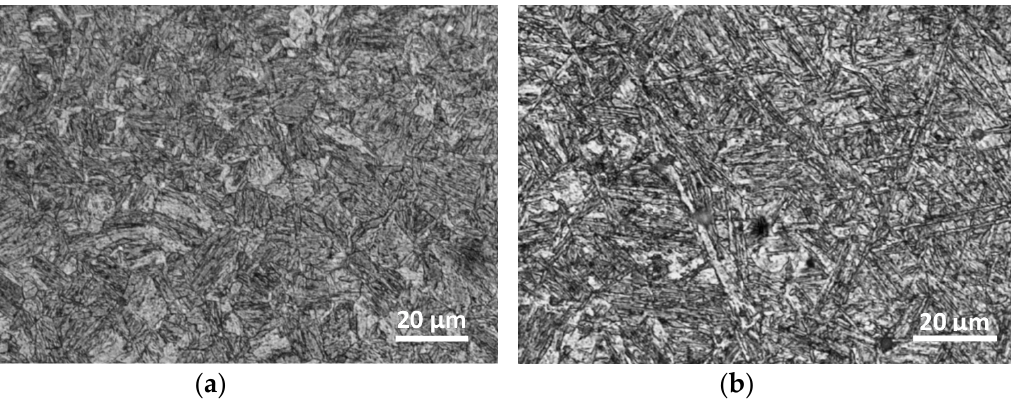
Figure 6. Microstructure of the joint cross-section without ( a ) and with the use of helium micro-jet cooling ( b ), etched Nital,